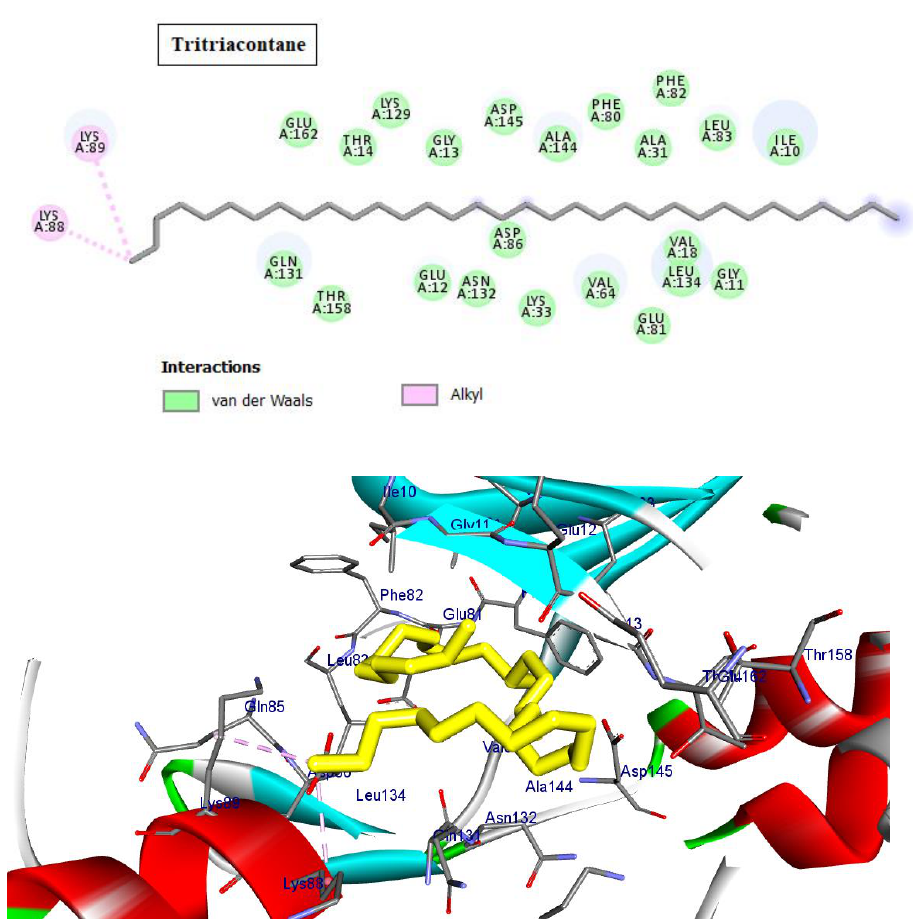
Figure 2. Two-dimensional and three-dimensional images of tritriacontane docked into the ATP binding site CDK-2 enzyme.